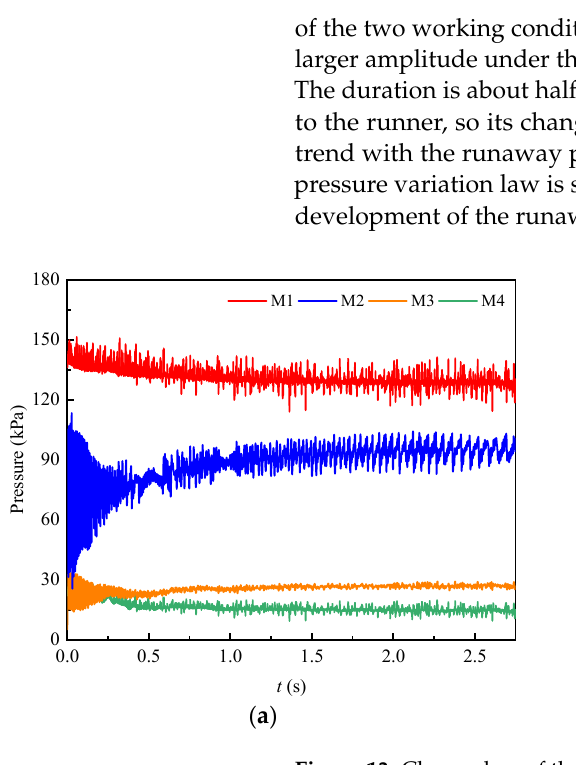
Figure 13. Change law of the pressure pulsation at the monitoring point. ( a ) 0.85 Q BEP . ( b ) 1.1 Q BEP . To determine the time-varying characteristics of the frequency corresponding to the pressure during the runaway of the turbine, the short-time Fourier transform method [19,32] was used in this work to transform the pressure pulsation time domain values of M2 and M3, as shown in Figure 14. The M2 and M3 points show obvious high-amplitude pulsation. The pressure pulsation in the runner domain is related to the rotor–stator interaction. Accordingly, the high amplitude value of the M2 point first appears at the runner blade frequency and its higher harmonics. Furthermore, the main frequency and the magnitude of each harmonic frequency gradually increase with time. These factors remain stable under the runaway state, and the leaf frequency and its higher harmonics always exist in the whole process of runaway development. The comparison of the time–frequency diagrams of points M2 and M3 demonstrates that the change of point M3 is basically the same as that of point M2; only the amplitude is small, indicating that the flow at the inlet of the draft tube is greatly affected by the runner. In the comparison of the stable working conditions, the main frequency range corresponding to M2 and M3 significantly increases during the runaway process. The highest point corresponding to the main frequency gradually moves to the high frequency, and the greater the flow rate, the more obvious the change. This phenomenon occurs because the speed of the runner continues to increase during the development of the runaway, causing its main frequency to gradually increase along the direction of the speed change, and the main frequency also reaches the maximum when the speed reaches the runaway speed.